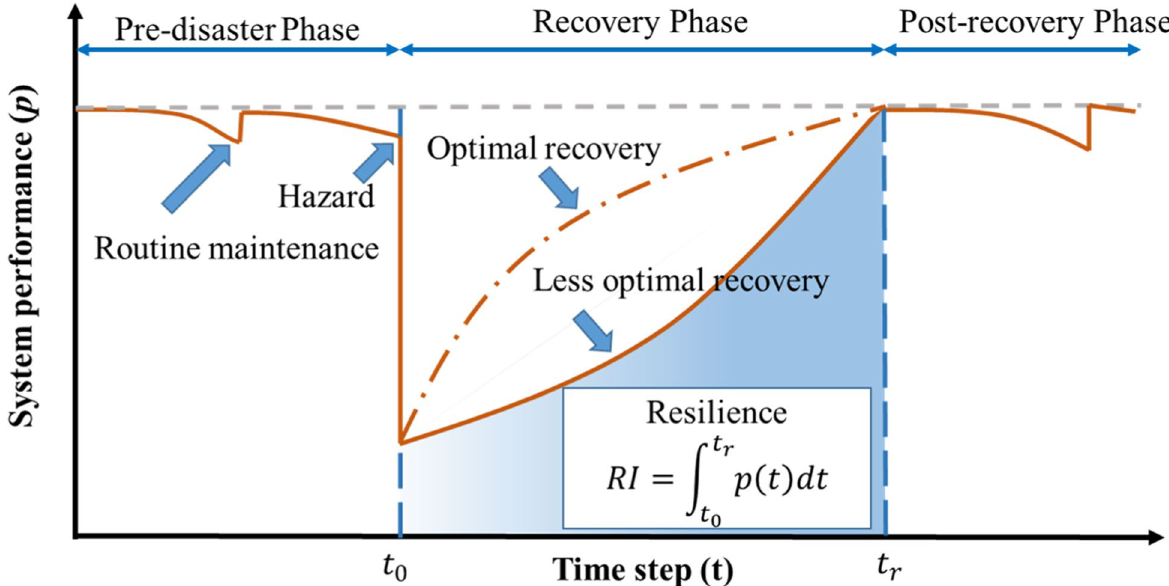
Fig. 1. Illustration of the concept of resilience and maintenance